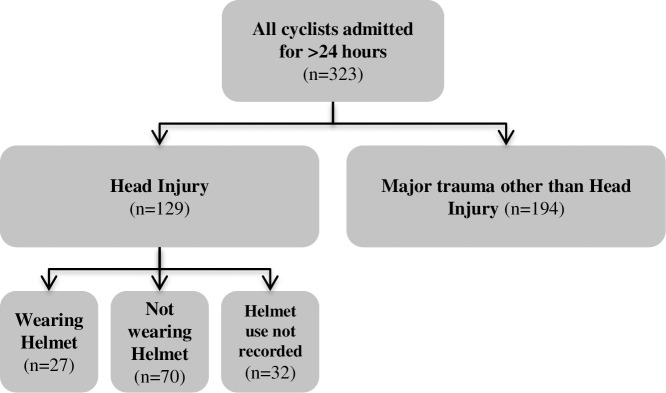
Cyclists included in the analysis.